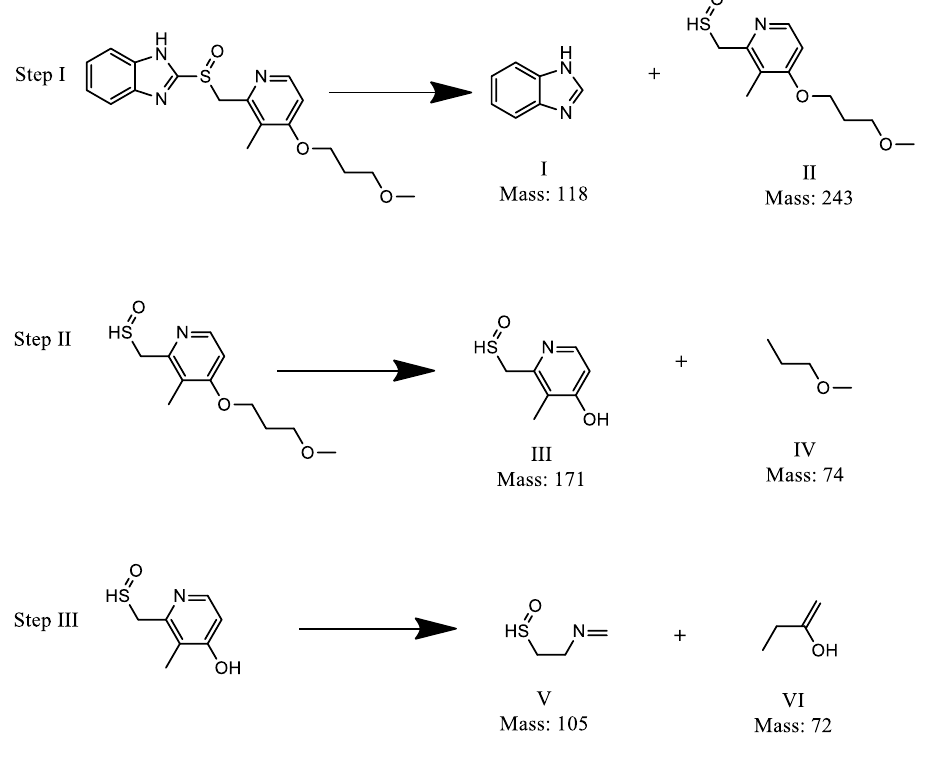
Figure 14. Plausible degradation route of